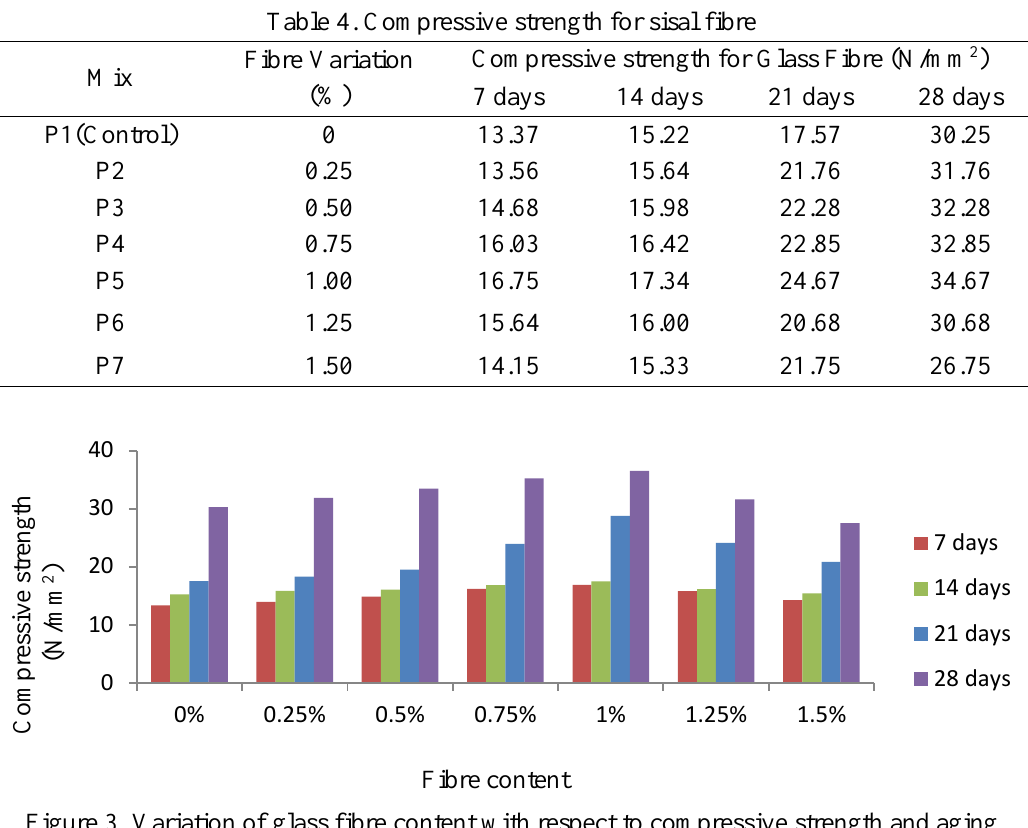
Figure 3. Variation of glass fibre content with respect to compressive strength and aging